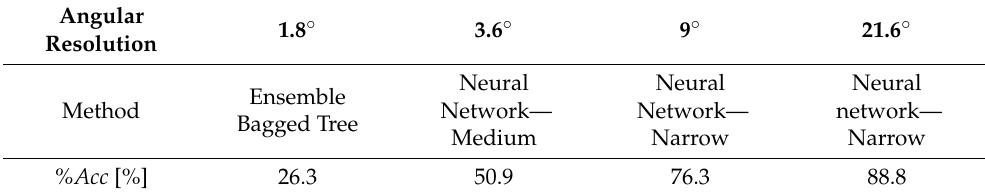
Neural Network— Medium